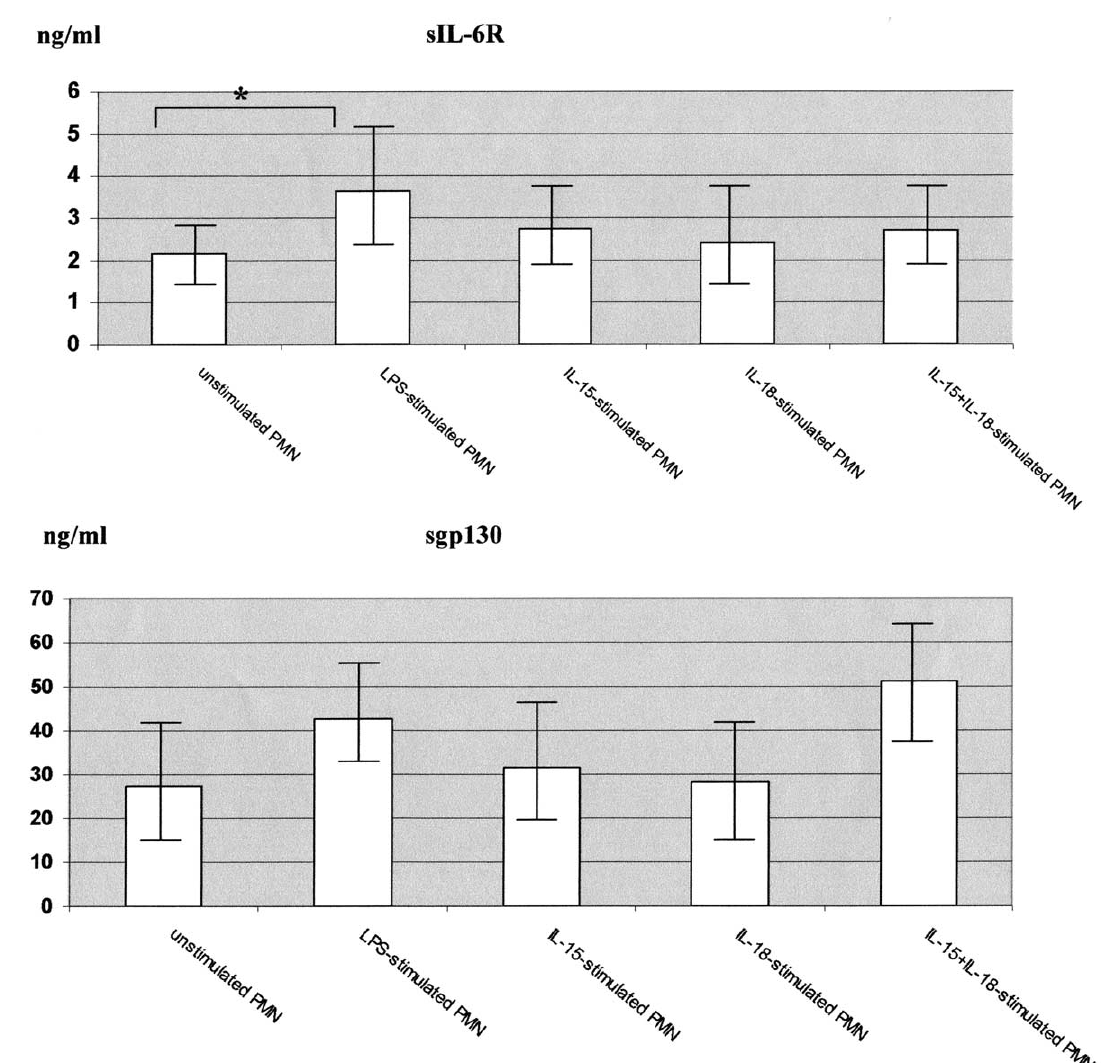
FIG. 2. The concentrations of sIL-6R and sgp130 in the culture supernatants of LPS-stimulated, rhIL-15-stimulated and rhIL-18- stimulated PMN. * Statistical difference with unstimulated cells (p B /